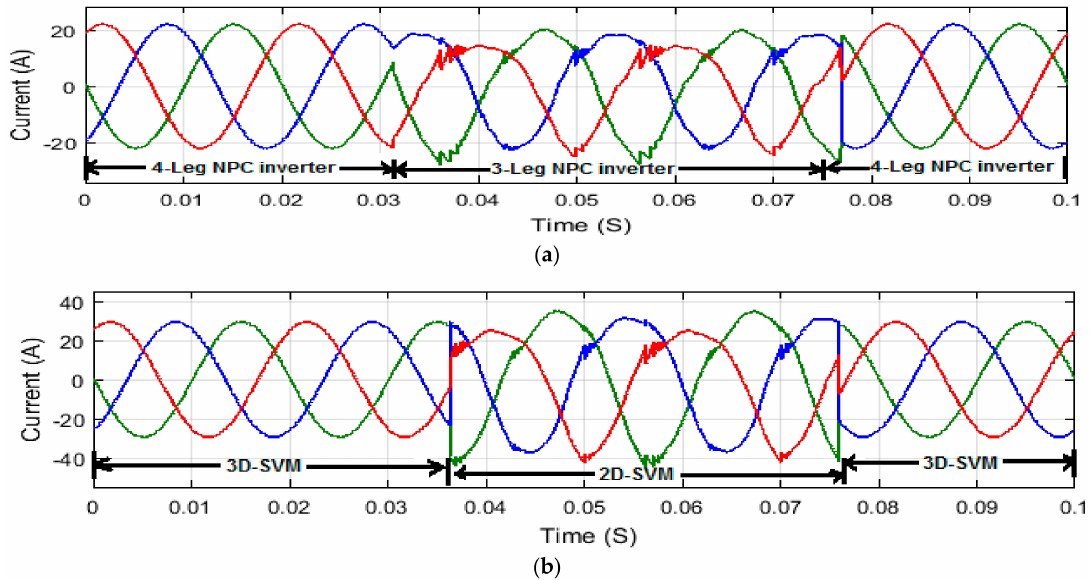
Figure 14. Comparison of output current with various control schemes ( a ) 4-leg NPC inverter VS 3-leg NPC inverter using effectual 3D-SVM; and ( b ) 3D-SVM VS 2D-SVM for 4-leg NPC inverter. The THD analysis of proposed 3-phase 4-leg 3-level NPC inverter system under balanced and unbalanced conditions analysed for output voltage and current with effectual 3D-SVM and 2D-SVM